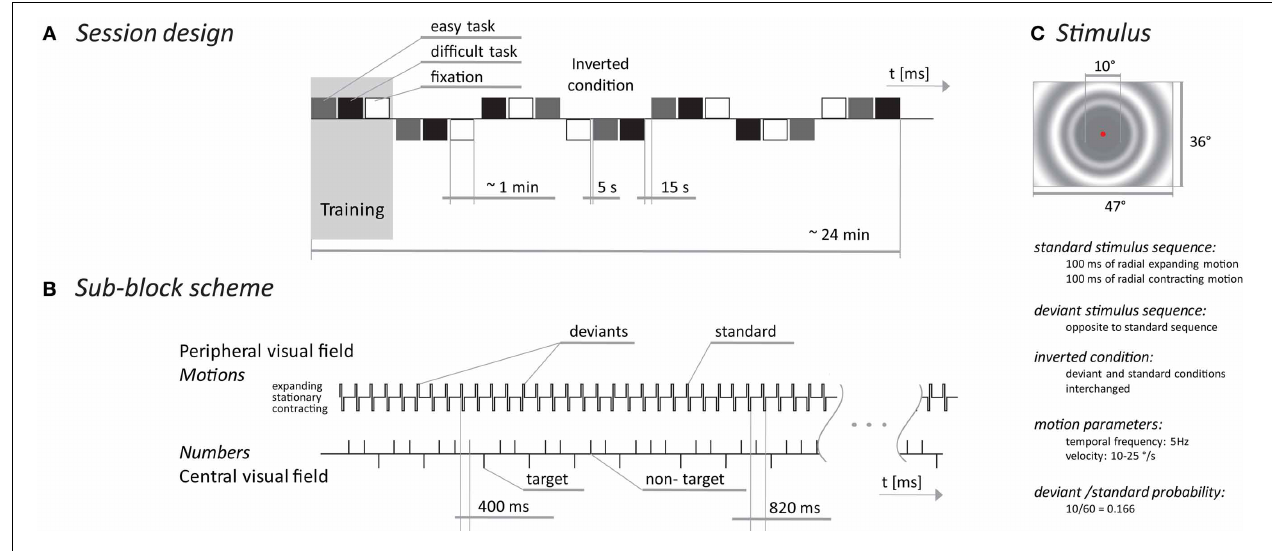
FIGURE 1 | MMN experimental scheme. The session design (A) presents blocks (triplets) of sub-blocks with three different tasks. The sub-block scheme (B) shows a temporal diagram of events occurring in the peripheral